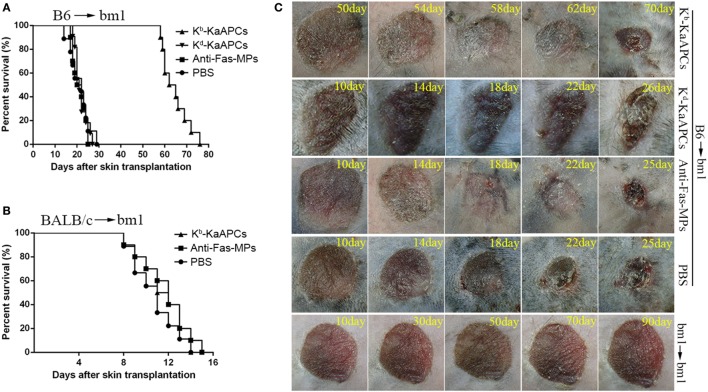
Killer artificial antigen-presenting cells (KaAPCs) prolong alloskin graft survival and reduce local allograft rejection. Ear dorsal tissues of C57BL/6J (B6) mice were grafted onto the dorsal of bm1 mice and followed by i.v. injection of Kb-KaAPCs, Kd-KaAPCs, anti-Fas-MPs (1 × 107 MPs/mouse/time point), or PBS on days 9, 11, and 13 posttransplantation. (A) Kaplan–Meier survival plots for alloskin grafts in the bm1 mice grafted with ear skin of B6 mice in each treatment group. Kb-KaAPCs mean the poly lactic-co-glycolic acid microparticles (PLGA MPs) co-displaying H-2Kb-Ig dimers and anti-Fas monoclonal antibodies (mAbs); Kd-KaAPCs mean the PLGA MPs co-displaying H-2Kd-Ig dimers and anti-Fas mAbs; anti-Fas-MPs mean the PLGA MPs displaying only anti-Fas mAbs. (B) Kaplan–Meier survival plots for alloskin grafts in the bm1 mice grafted with ear skin of BALB/c mice, a third-party alloskin transplant model followed by treatment as described on days 5, 7, and 9 days posttransplantation. (C) Representative pictures of alloskin grafts on the indicated days in the KaAPC group and control groups. The bm1 autograft transplantation was performed to assure a correct transplant procedure.